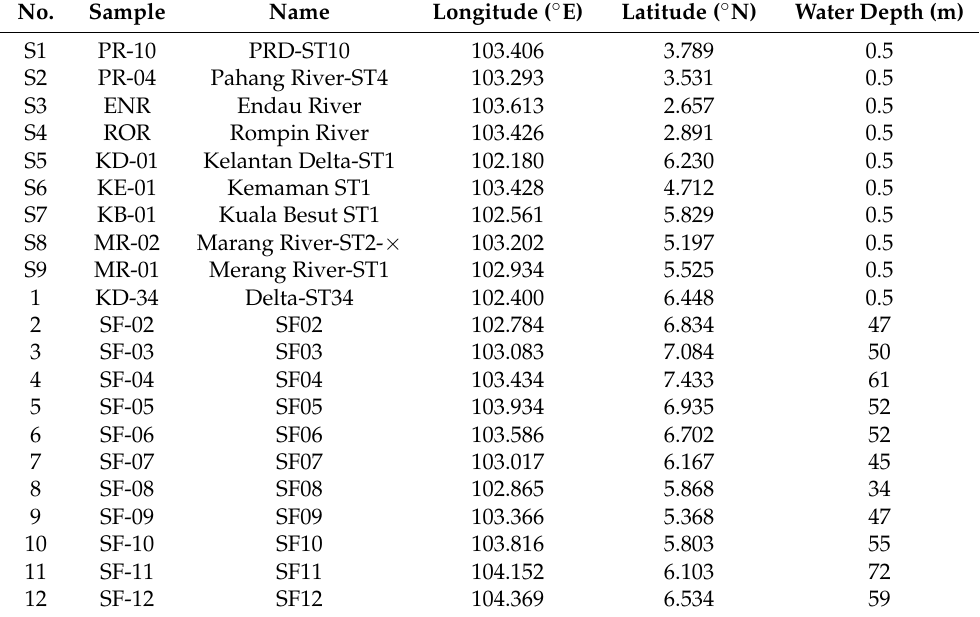
Table 1. Information of surface sediment samples taken from the eastern Malaysia and neighbouring Sunda Shelf, southern South China